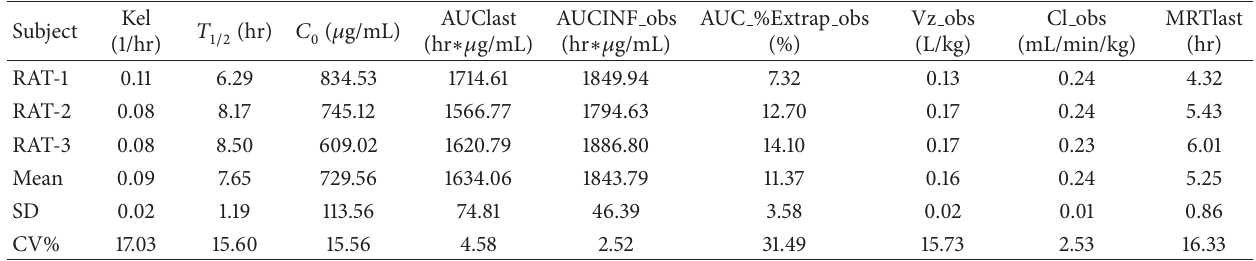
Table 4: Pharmacokinetic parameters of CrEL-PEG after intravenous administration at 0.018 g/kg dose (PEG Oligomers) in male Sprague Dawley rats.